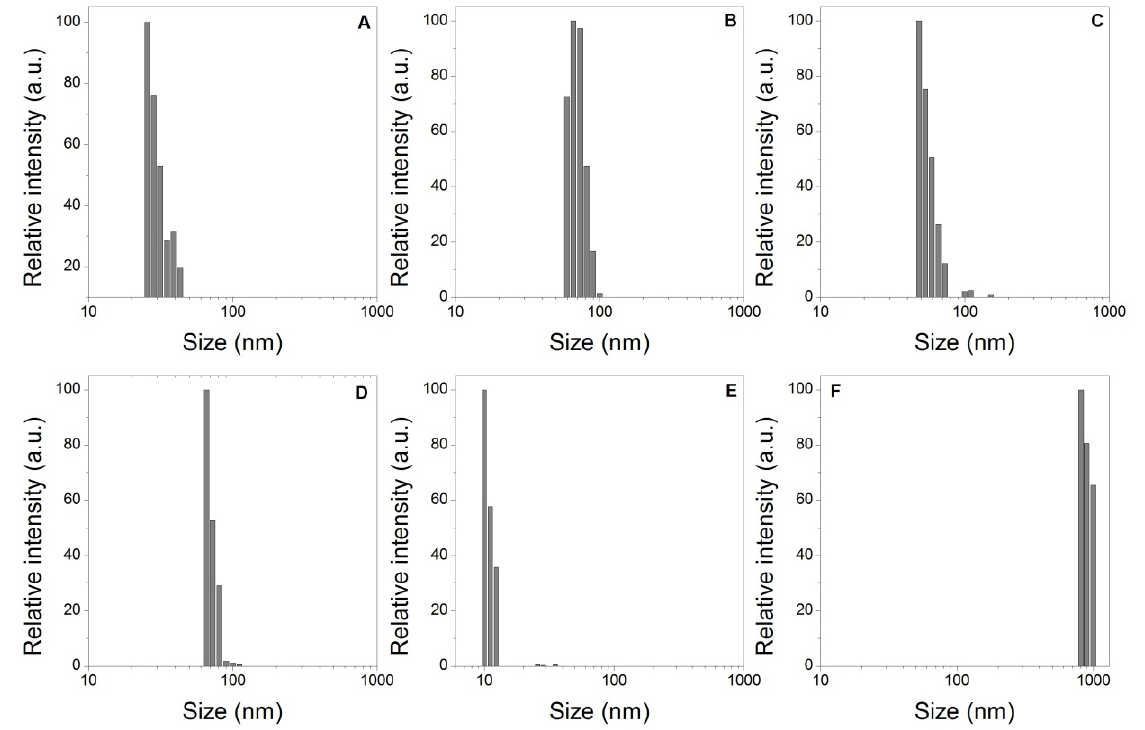
Figure 7. Dynamic light scattering particle size distribution of wastewaters: ( A ) WC + HNa. ( B ) WSM+ HNa. ( C ) WSL + HNa. ( D ) WC + HK. ( E ) WSM+ HK. ( F ) WSL + HK.